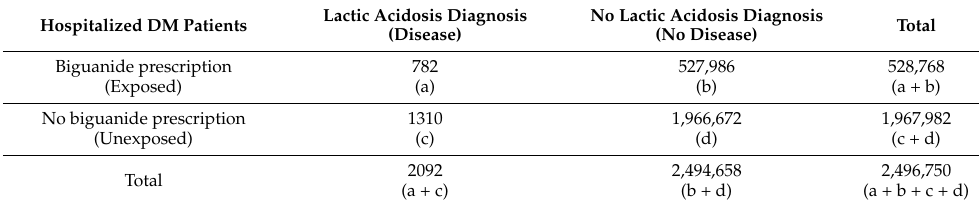
Table 1. Exposure to biguanides and LA outcomes among hospitalized DM patients.